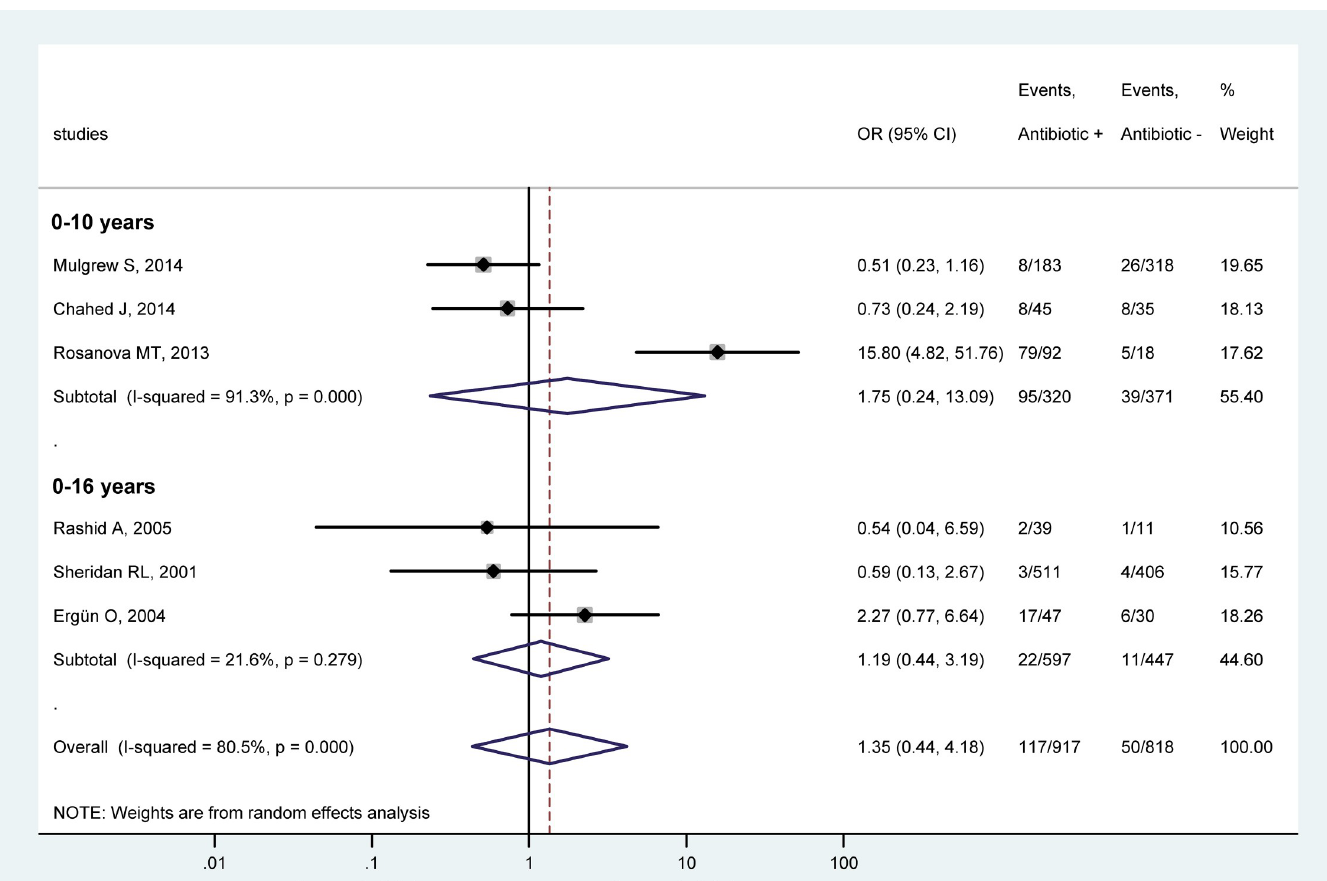
Fig 3. Forest plot of the odds ratios (ORs) for all infectious complications in pediatric patients of 0–10 years (top) and 0–16 years (bottom) with burn injuries who received versus those who did not receive systemic antibiotic prophylaxis.